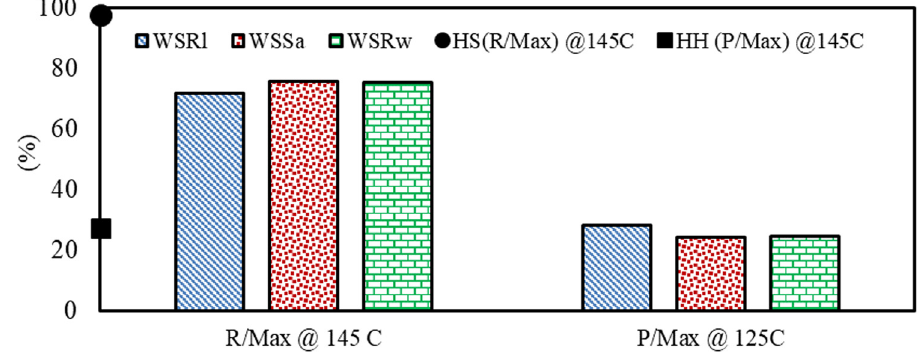
Figure 25: Final percentages of recovered and permanent strain at the termination of the third cycle.